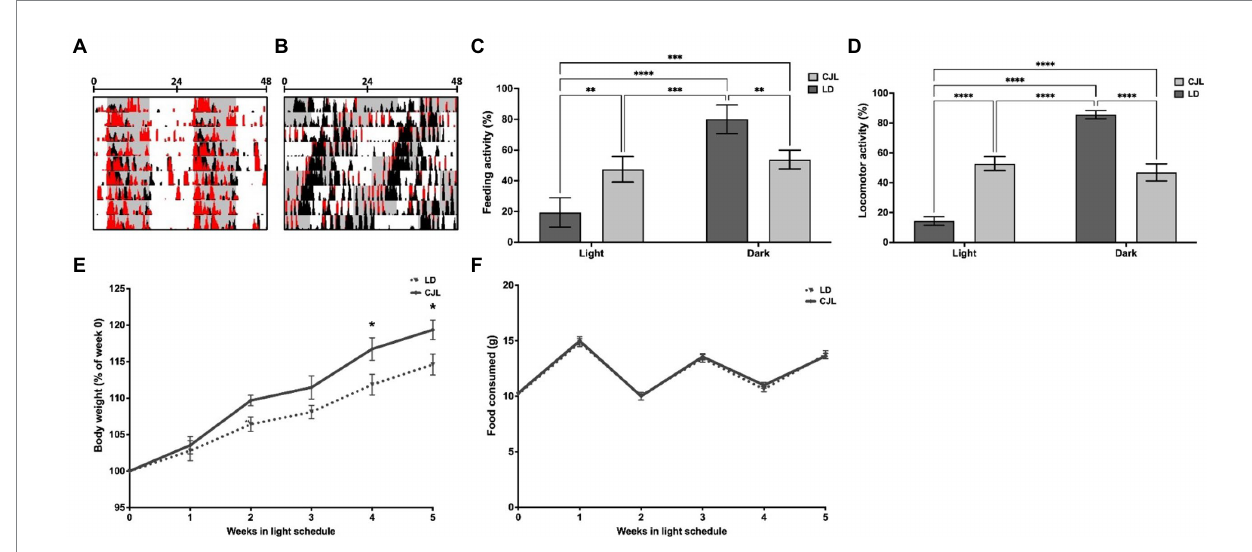
FIGURE 1 CJL induces behavioral desynchronization of general activity and feeding-fasting rhythms, together with an increase in body weight. Representative actograms of locomotor activity of mice under LD (A) and CJL (B) . Histograms in black represent general activity (black) and feeding activity (red). Mice under LD present general and feeding activity bouts at the dark phase with a period of 24 h (24 h ± 0.02 h, n = 4). Mice under CJL showed behavioral desynchronization with a period close to 21 h (20.97 h ± 0.02 h, n = 4). (C) light/dark feeding activity distribution (as a percentage of total) of mice under LD and CJL. Feeding activity under LD was significantly higher in the dark, while no significant difference was found between light and dark in mice under CJL; Two-way ANOVA, p < 0.0001, F = 41.27 for interaction; p < 0.0001, F = 63.21 for light schedule, p = 0.826, F = 0.050 for light/dark; n = 4, followed by Tukey’s multiple comparisons test: **** p < 0.0001, *** p < 0.001, ** p < 0.01; n = 4. (D) Light/dark general activity distribution (as a percentage of total) of mice under LD and CJL. General activity under LD was significantly higher in the dark, while no significant difference was found between light and dark in mice under CJL; Two-way ANOVA, p < 0.0001, F = 430.2 for interaction; p = 0.953, F = 0.003 for light schedule; p < 0.0001, F = 309.1 for light/dark; n = 6 per group; Tukey’s multiple comparisons test: **** p < 0.0001. (E) Body weight increment (as a percentage of week 0) is significantly higher in mice under CJL conditions compared to LD. Repeated measures Two-way ANOVA, p = 0.0036, F = 2.36 for interaction; p < 0.0001, F = 92.54 for weeks; p = 0.0040, F = 9,948 for light schedule; n = 4, followed by Sidak’s multiple comparisons test: ** p < 0.005, * p < 0.05; n = 4. (F) Food consumed (g) remained constant over the weeks, without differences between LD and CLJ conditions. Two-way RM ANOVA, p = 0.9682, F = 0.184 for interaction; p < 0.0001, F = 103 for weeks; p = 0.6697, F = 0.1858 for light schedule; n = 4, followed by Sidak’s multiple comparisons test: ns; n =